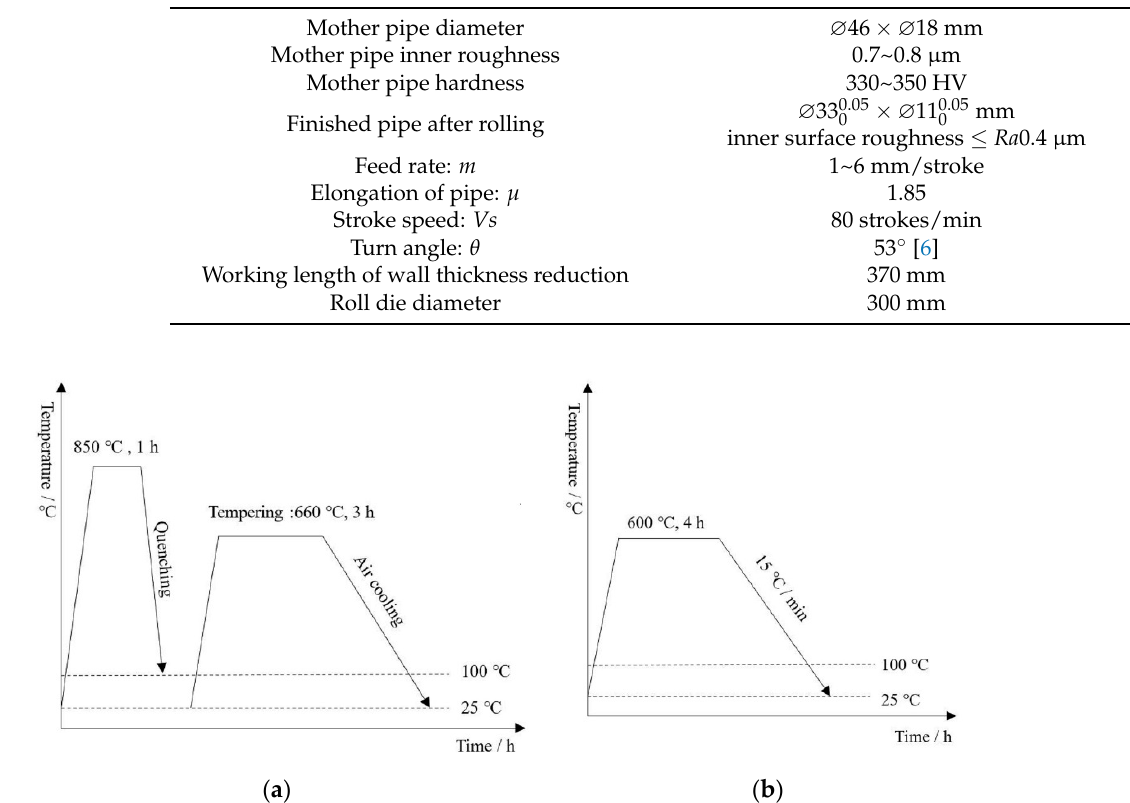
Figure 1. Heat treatment process diagrams of experiment pipe ( a ) quenching and tempering before rolling; ( b ) vacuum tempering.